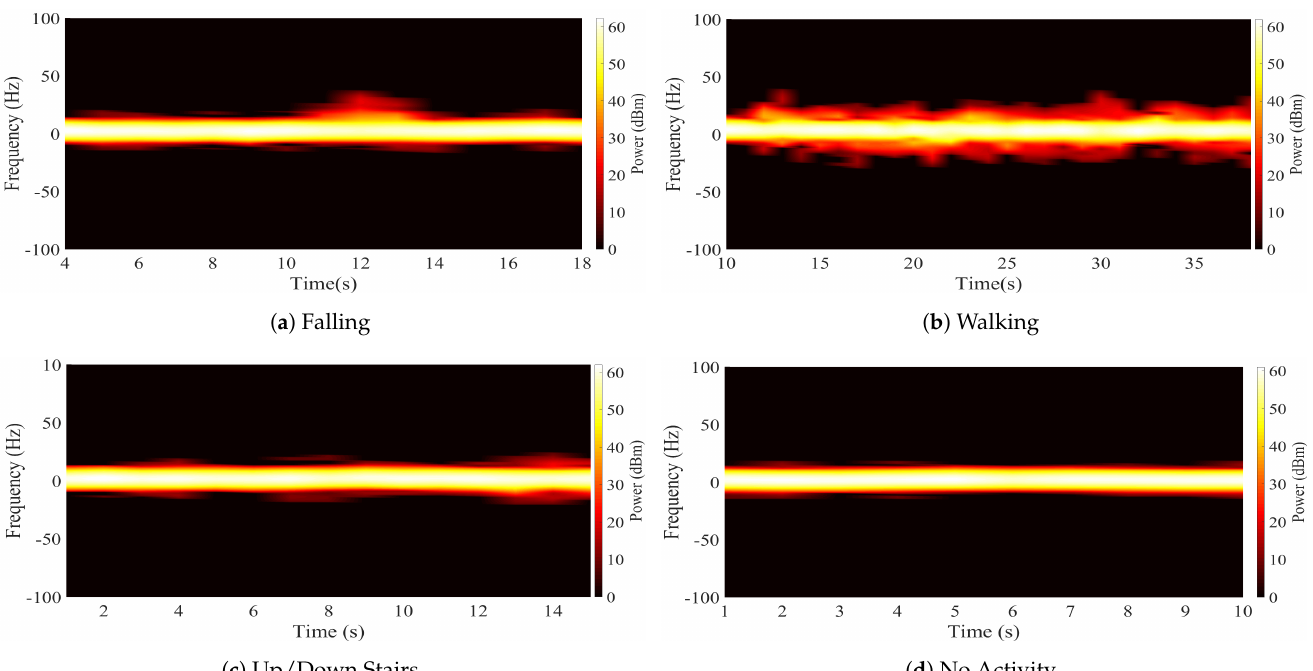
Figure 6. Spectrograms of the activities performed during the experimentation protocol after noise